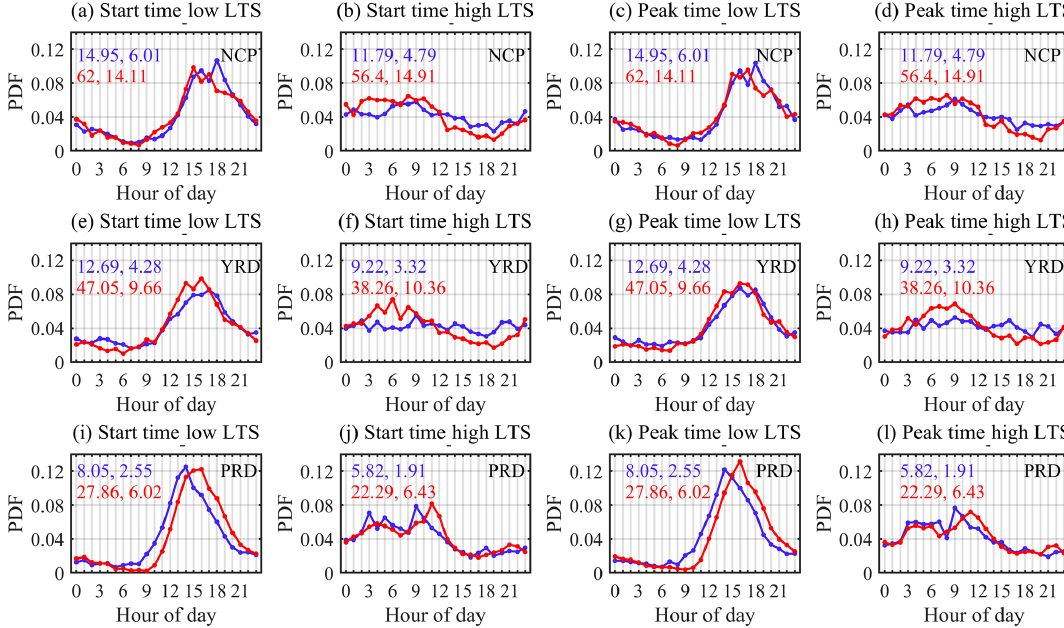
Figure 11. Same as Fig. 10, but under low-LTS conditions and high-LTS conditions. LTS represents low troposphere